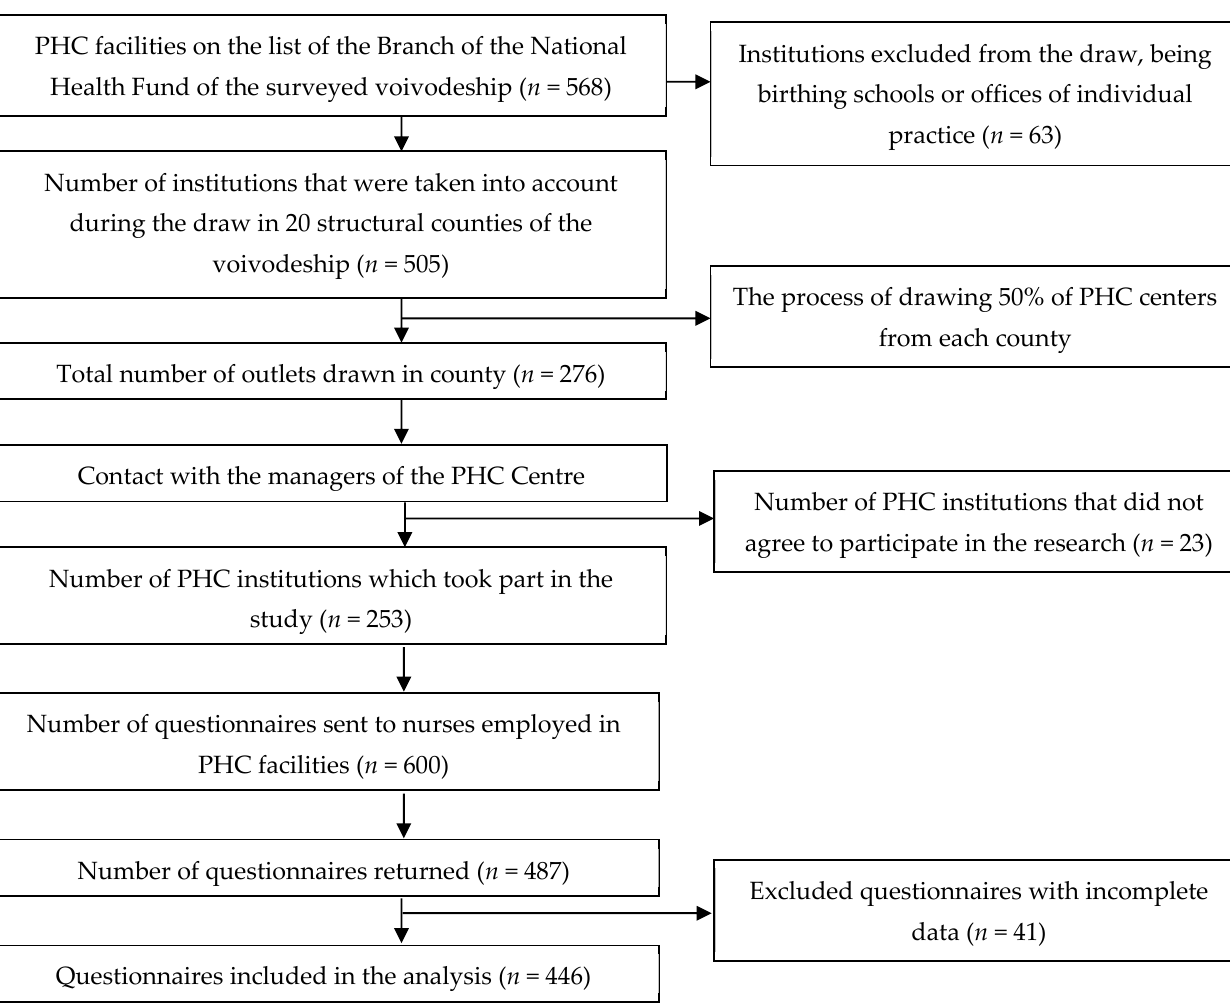
Figure 2. Procedure for collecting PHC Centres and respondents’ forms.